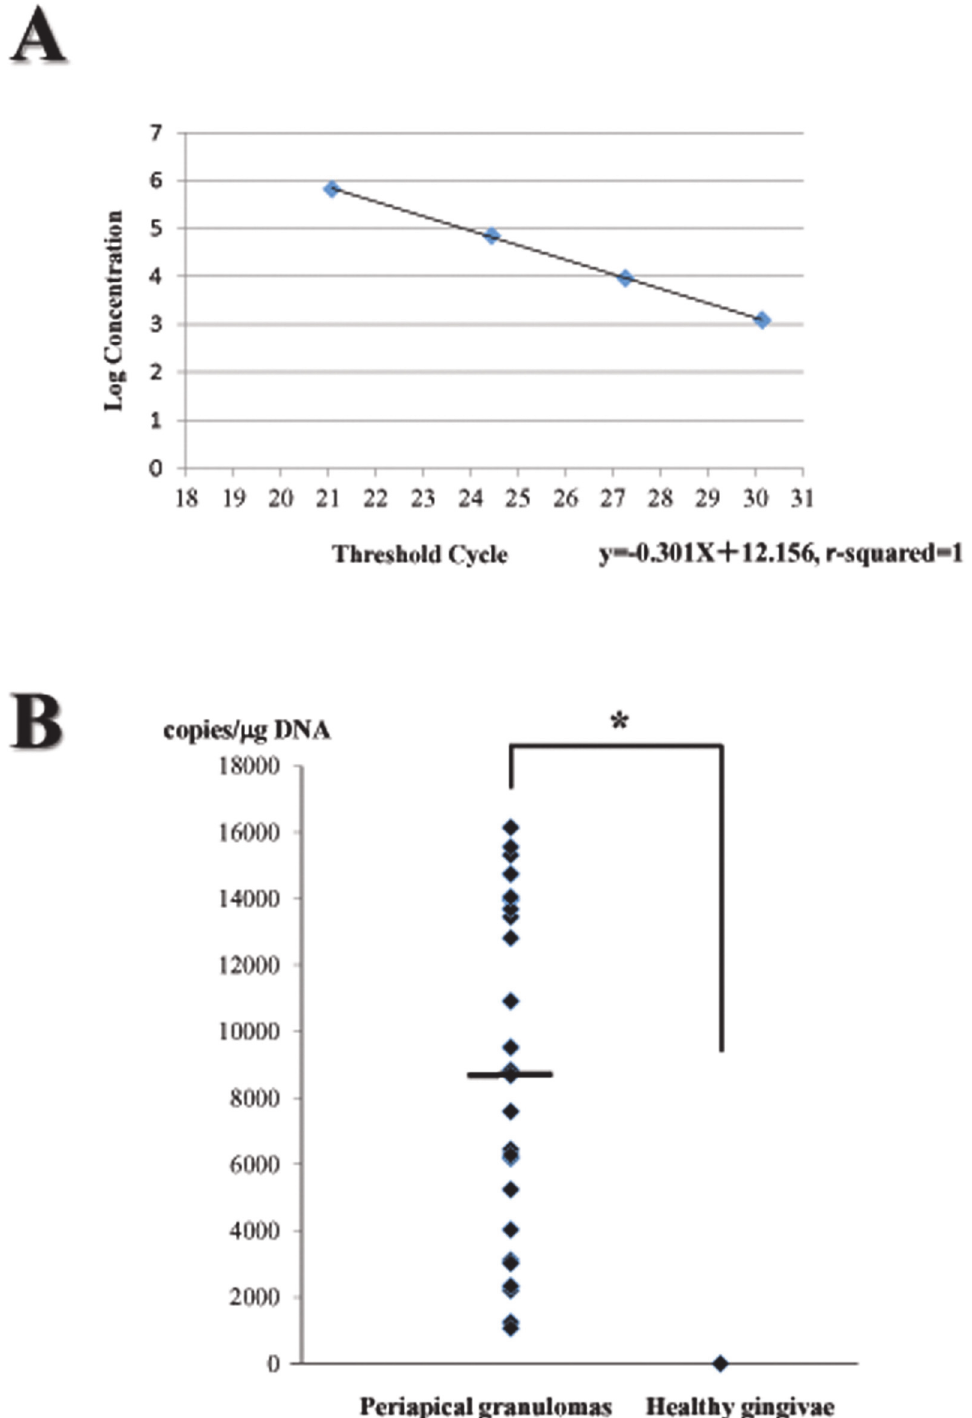
Fig 3. Quantitative real time PCR analysis. (A) Standard curve to determine the copies of EBV DNA in specimens. EBV DNA (approximately 1x10 6 copies/ μ l) was diluted in ten-fold serially. Each diluted DNA was amplified using real-time PCR simultaneously at the time of amplification for DNA extracted from periapical granulomas and healthy gingivae. (B) Detection of EBV DNA in periapical granulomas and healthy gingivae. The copy of EBV DNA in each specimen was calculated using the standard curve. The median of EBV DNA copies in periapical granulomas was approximately 8688.01 per 1 μ g of total DNA, as shown by a horizontal bar. * showed statistical difference using Mann-Whitney U test ( p =